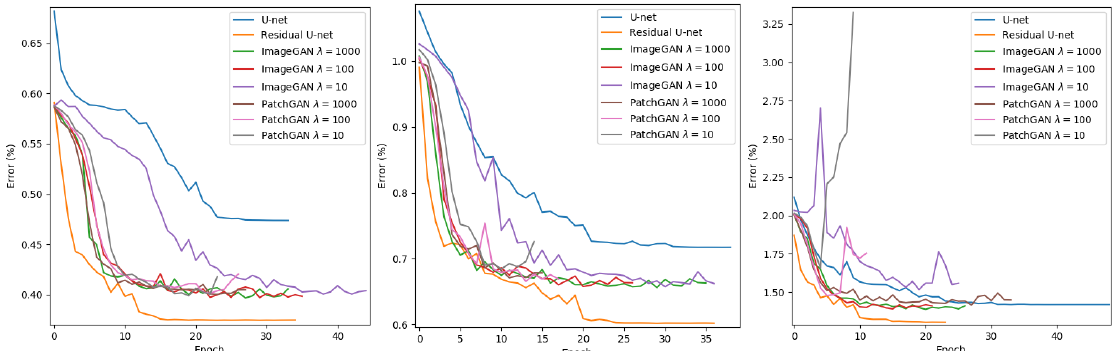
Figure 9. Learning curves of GANs using different discriminators and weighting factors at target scale 1:10,000 ( left ), 1:15,000 ( middle ) and 1:25,000 ( right ) based on validation